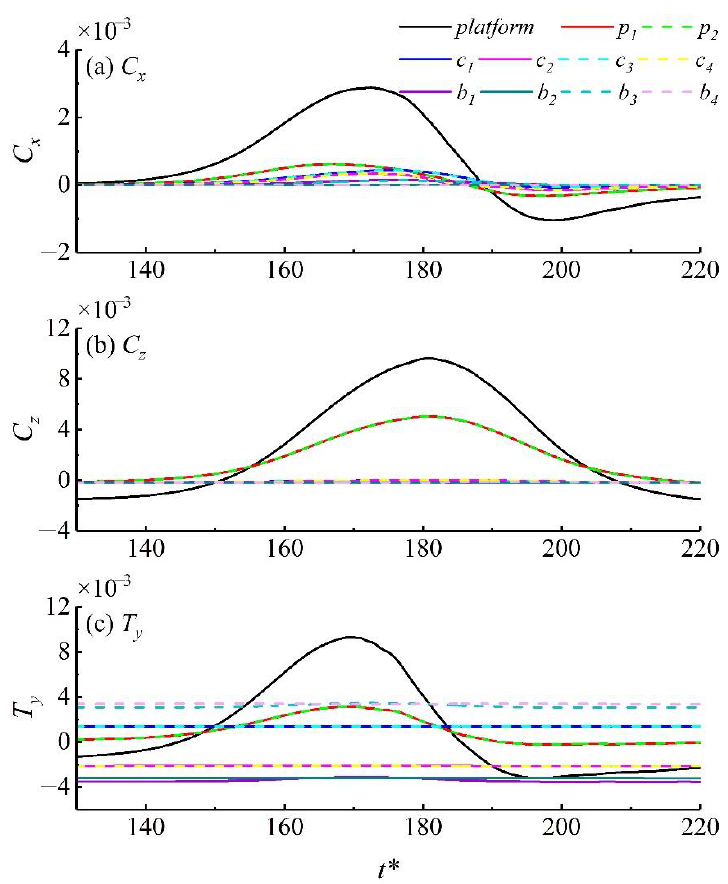
Figure 7. Forces and torques coefficients on each part of the platform versus time for Case A2. In order to be illustrated in the same figure as the pontoons and bracings, the torques on columns have been artificially reduced by 0.01